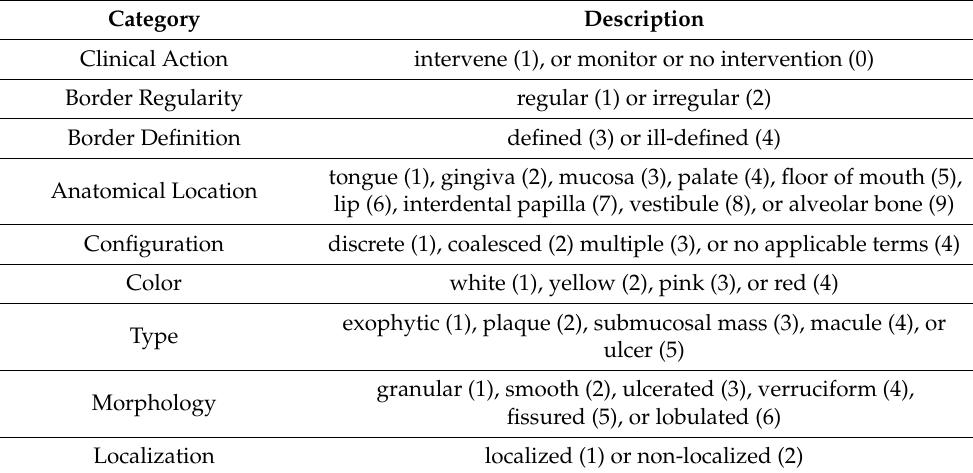
Table 1. A description of the taxonomy and the keys used to code each